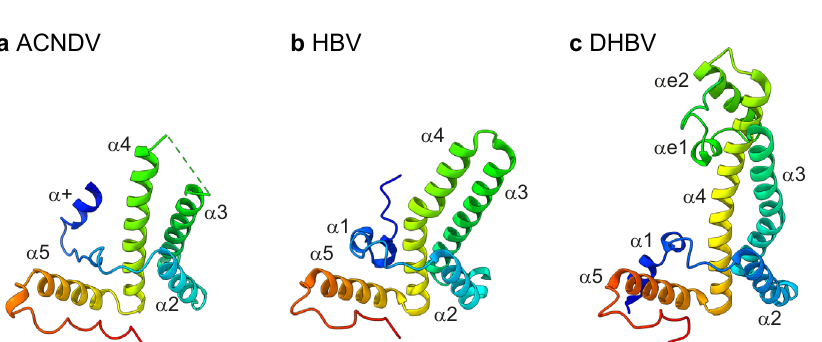
Fig.5|CpstructuresofACNDV,HBV,andDHBV.a ChainAACNDVCpatpH7.5.Thedottedlineindicateswherethenon-resolvedspikeresidueswereomitted. b ChainA HBV Cp T=3 (pdb 6ui6) 29 . c Chain A DHBV Cp T=4 (pdb 6ygh) 20